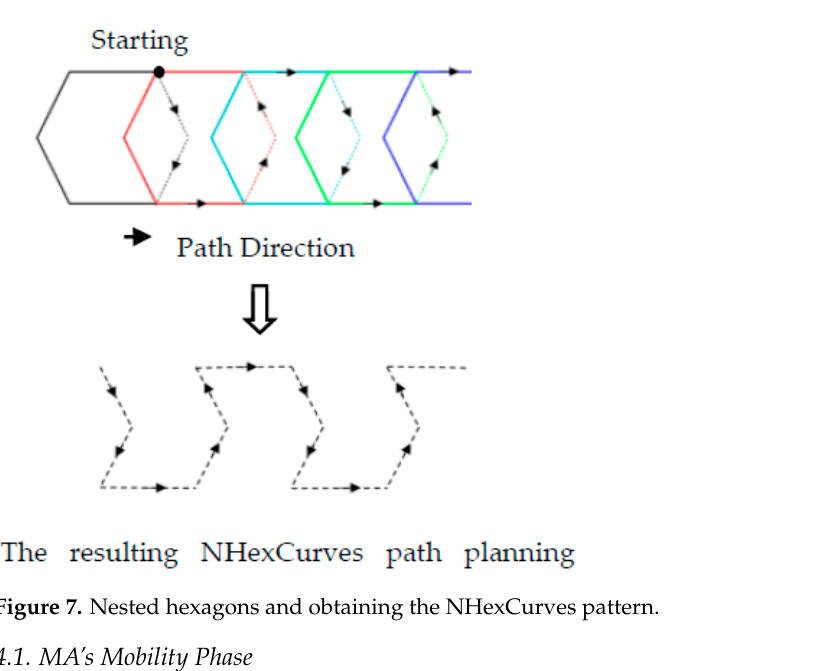
Figure 7. Nested hexagons and obtaining the NHexCurves pattern.